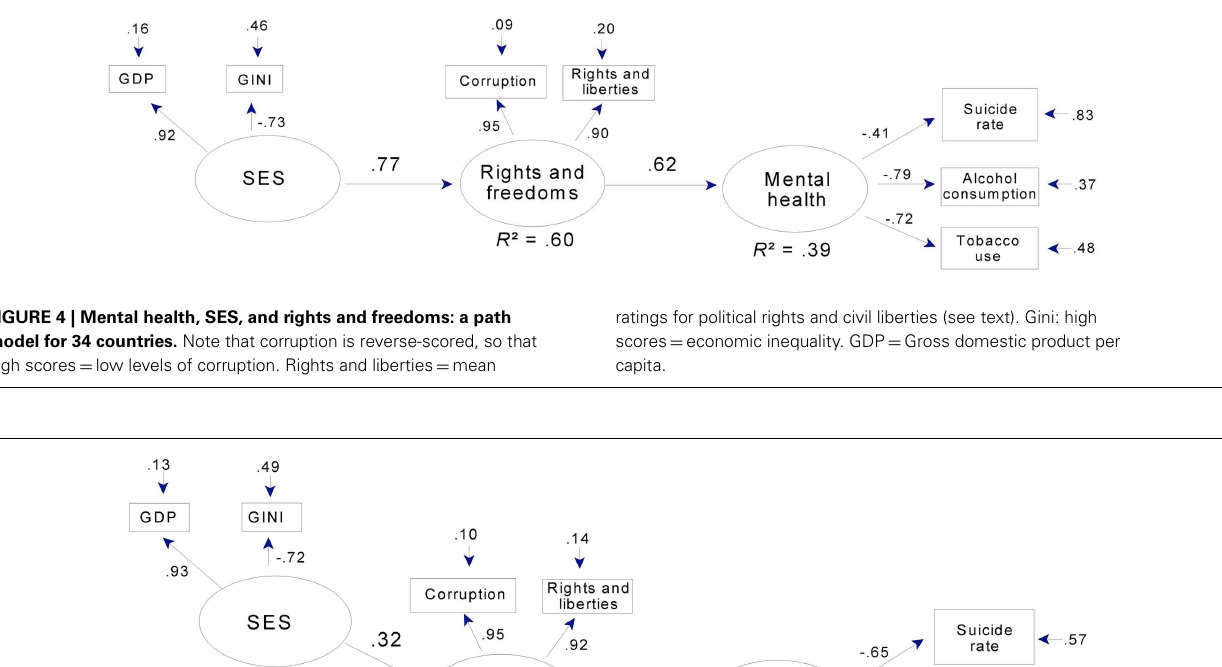
inequality. GDP = Gross domestic product per capita. % trust police = % of WVS sample expressing trust in police. % members of other organizations = % ofWVS sample who were active or inactive members in non-religious, non-labor